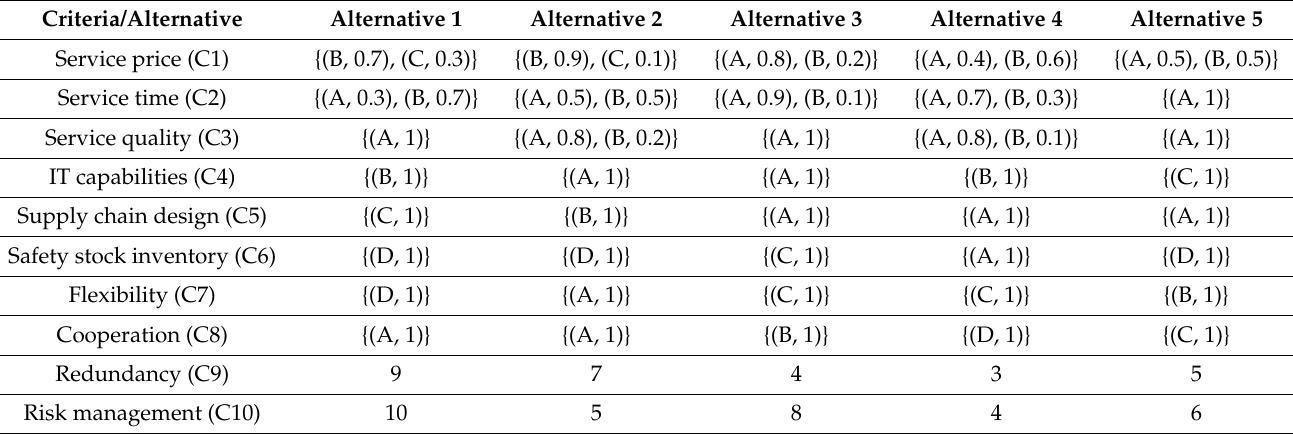
Table 10. Original assessment